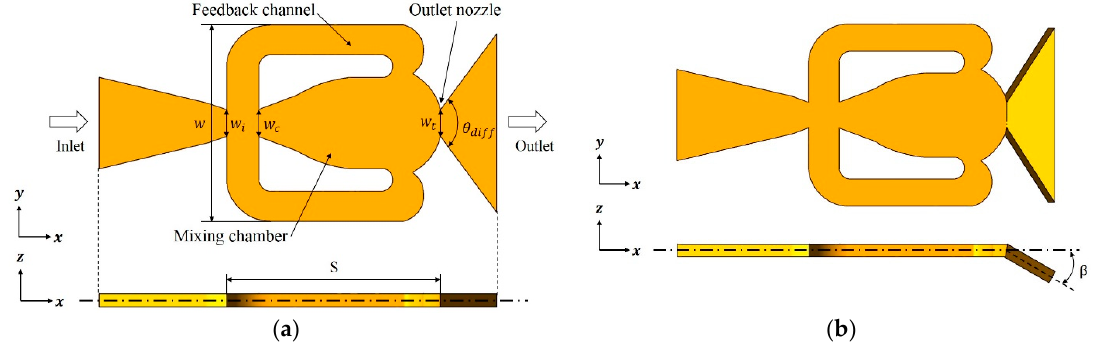
Figure 1. Flow configuration and fluidic oscillator model: ( a ) Reference model, ( b ) Model with bent outlet nozzle.